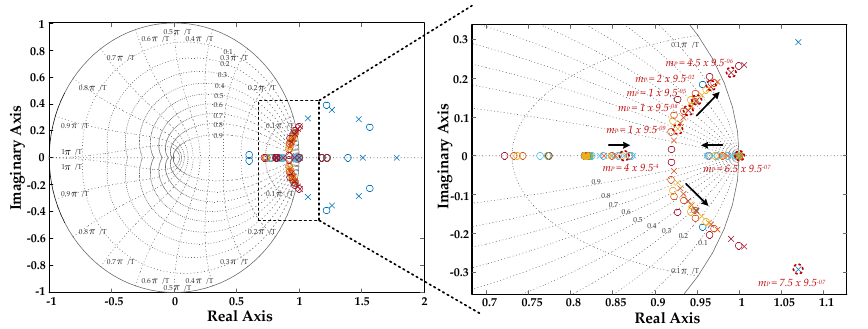
Figure 7. Effect of m P variation.